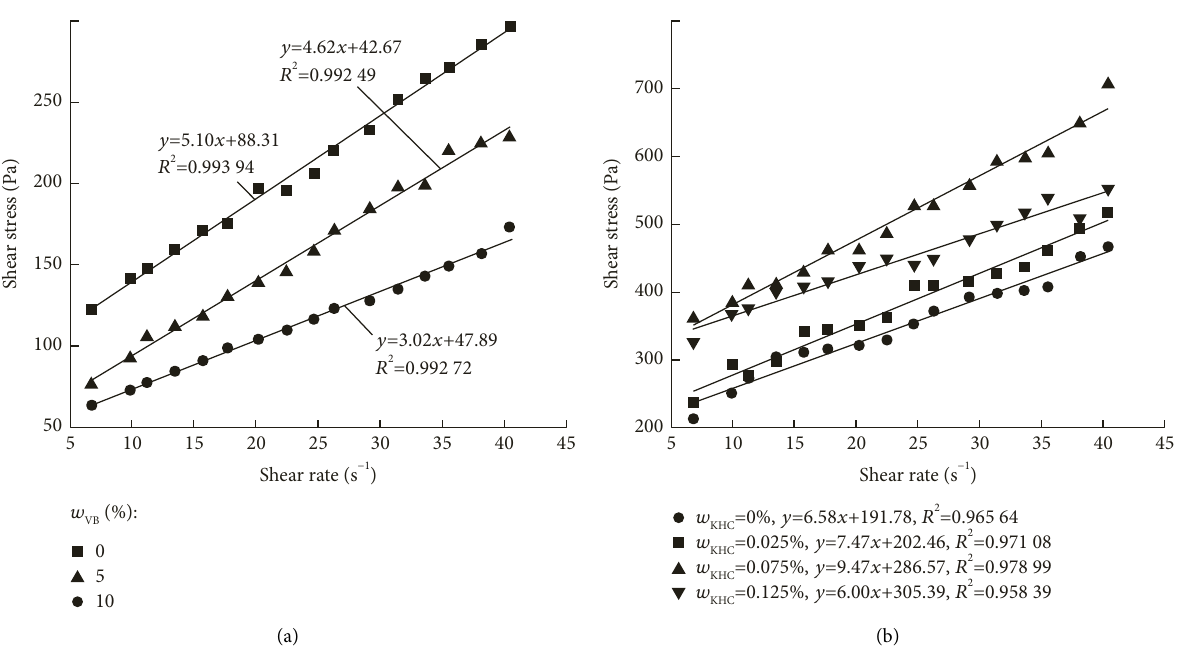
Figure 16: Effect of additional materials and additives on rheological properties of concrete, effect of aggregate (a), and effect of plasticizer (b) [36].